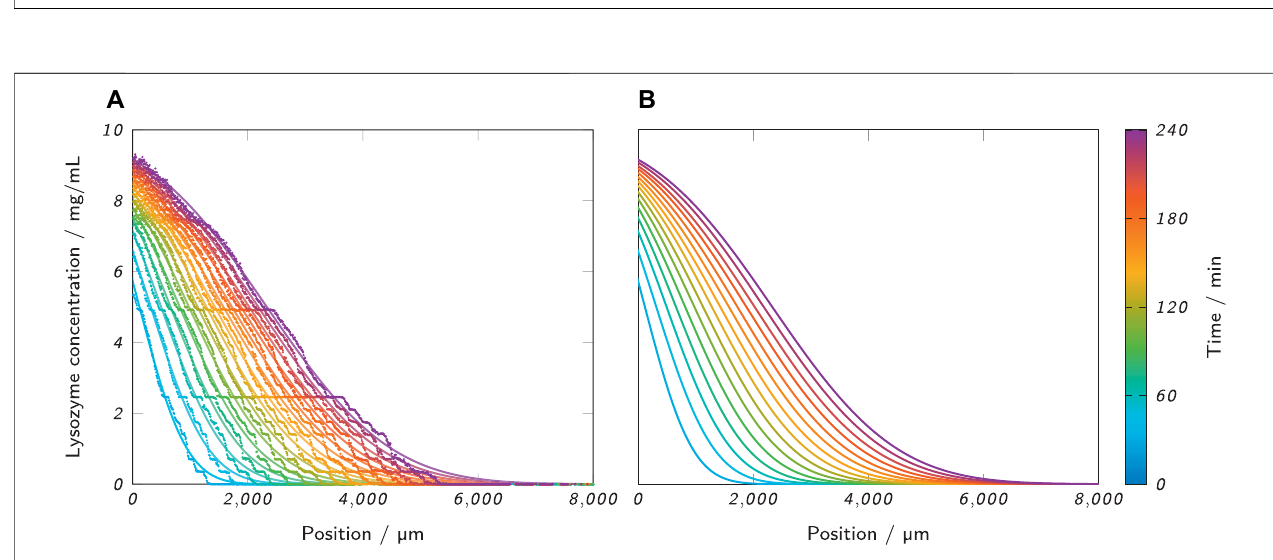
FIGURE 6 | (A) Lysozyme concentration pro fi les along the micro fl uidic channel at the analyzed time points, as obtained from an ActiPix ™ measurement. The scattered raw data are underlaid with the corresponding fi ts with Eq. 8 . The example shows a measurementwith 0.5% low-melt agarose as the hydrogel and 10 mg/ml lysozyme as the analyte solution. (B) Separate visualization of the same fi ts for better visibility.